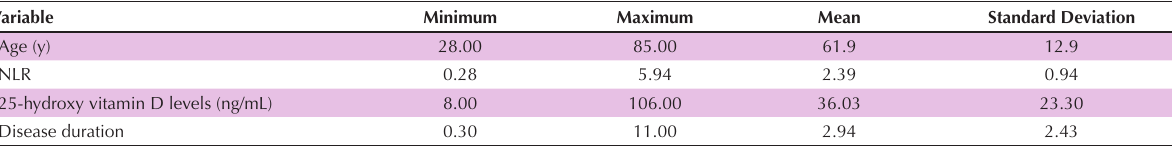
Table 1. Mean and standard deviation of the basic information Variable Minimum Maximum Mean Standard Deviation Age (y) 28.00 NLR 25-hydroxy vitamin D levels (ng/mL) Disease duration NLR: Neutrophil-to-lymphocyte